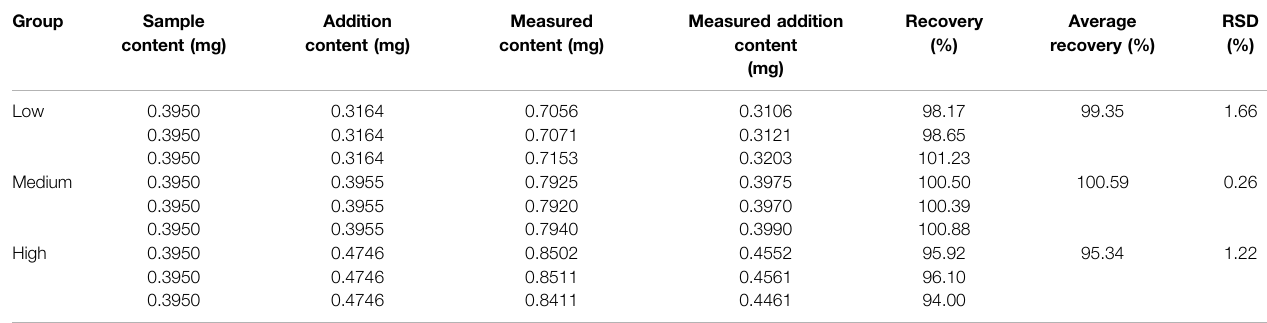
TABLE 4 | The recovery test results of specnuezhenide. Group Sample content (mg)